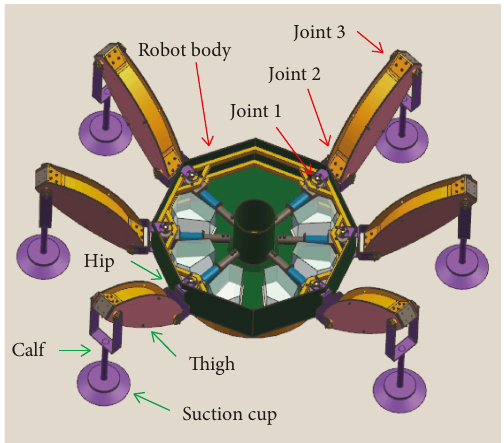
Figure 1: The CAD model of the wall-climbing hexapod